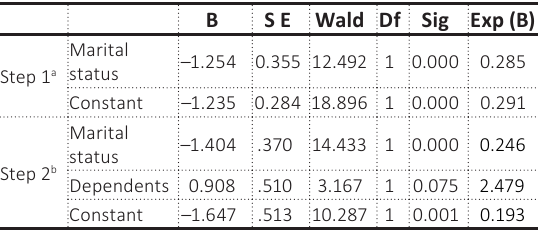
Table 6. Forward stepwise model